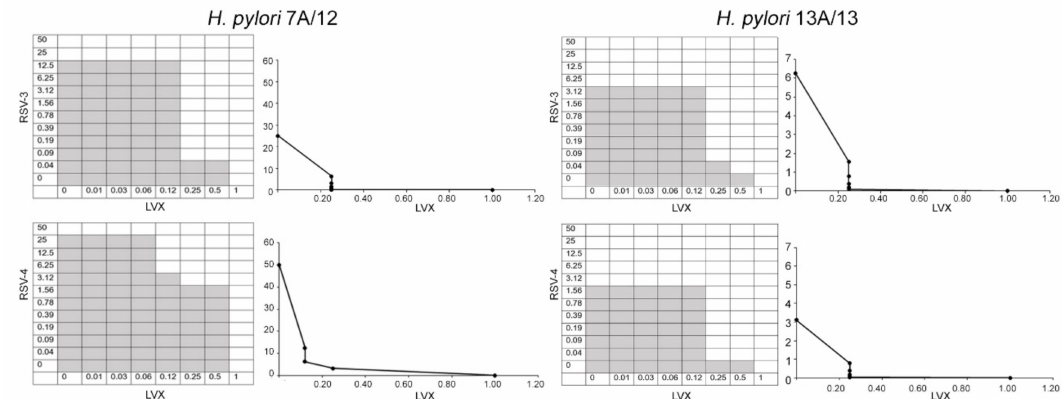
Figure 2. Checkerboard assay and isobolograms showing the synergism between RSV, RSV-3, or RSV-4 with LVX against resistant H. pylori 7A / 12 and MDR H. pylori 13A / 13 strains. On the left, representative checkerboard assays, the grey zone represents the bacterial growth and the white zone represents the growth inhibition in the presence of both RSV-3, RSV-4, and LVX. On the right, the isobolograms illustrate the related synergistic curves. The x -axis represents the dose of LVX and the y -axis represents the dose of RSV-3 and RSV-4. The imaginary straight line connecting the intercept points represents no interaction. Between this line and the synergistic curve, there is the synergistic area (FIC I ≤ 0.5) and additive area (FIC I > 0.5–4.0) interactions. Values above the straight line represent antagonistic interactions (FIC I ≥